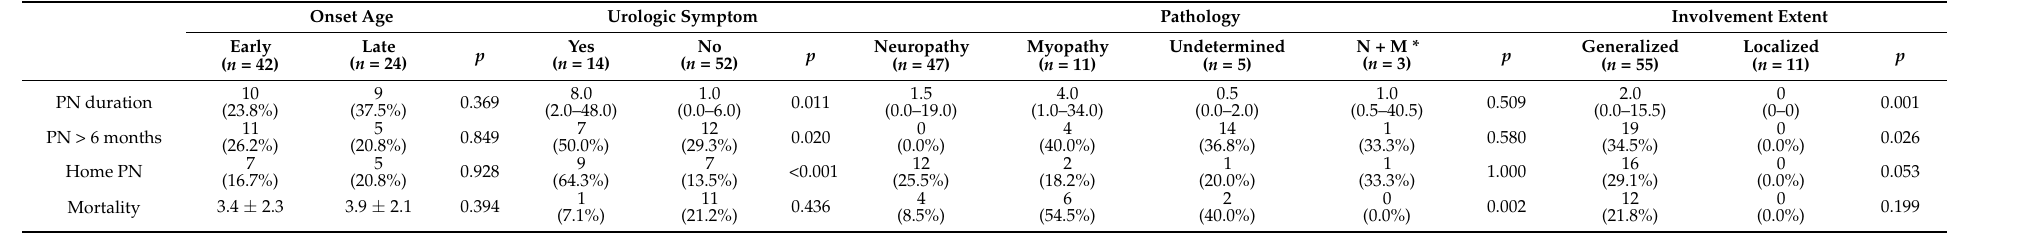
Table 4. Comparison of clinical outcomes according to